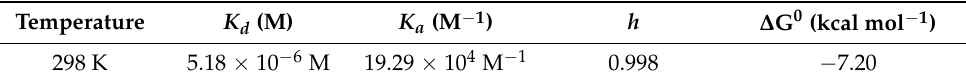
Figure 1. ( A ) UV absorption spectra of lysozyme (10 µ M) titrated with different concentrations of doxofylline (0–30 µ M). ( B ) plot of 1/(A − A 0 ) vs. 1/[doxofylline]. And ( C ) Hill plot. Table 1. Binding parameters for the interaction of doxofylline with lysozyme at 298 K obtained from UV–vis